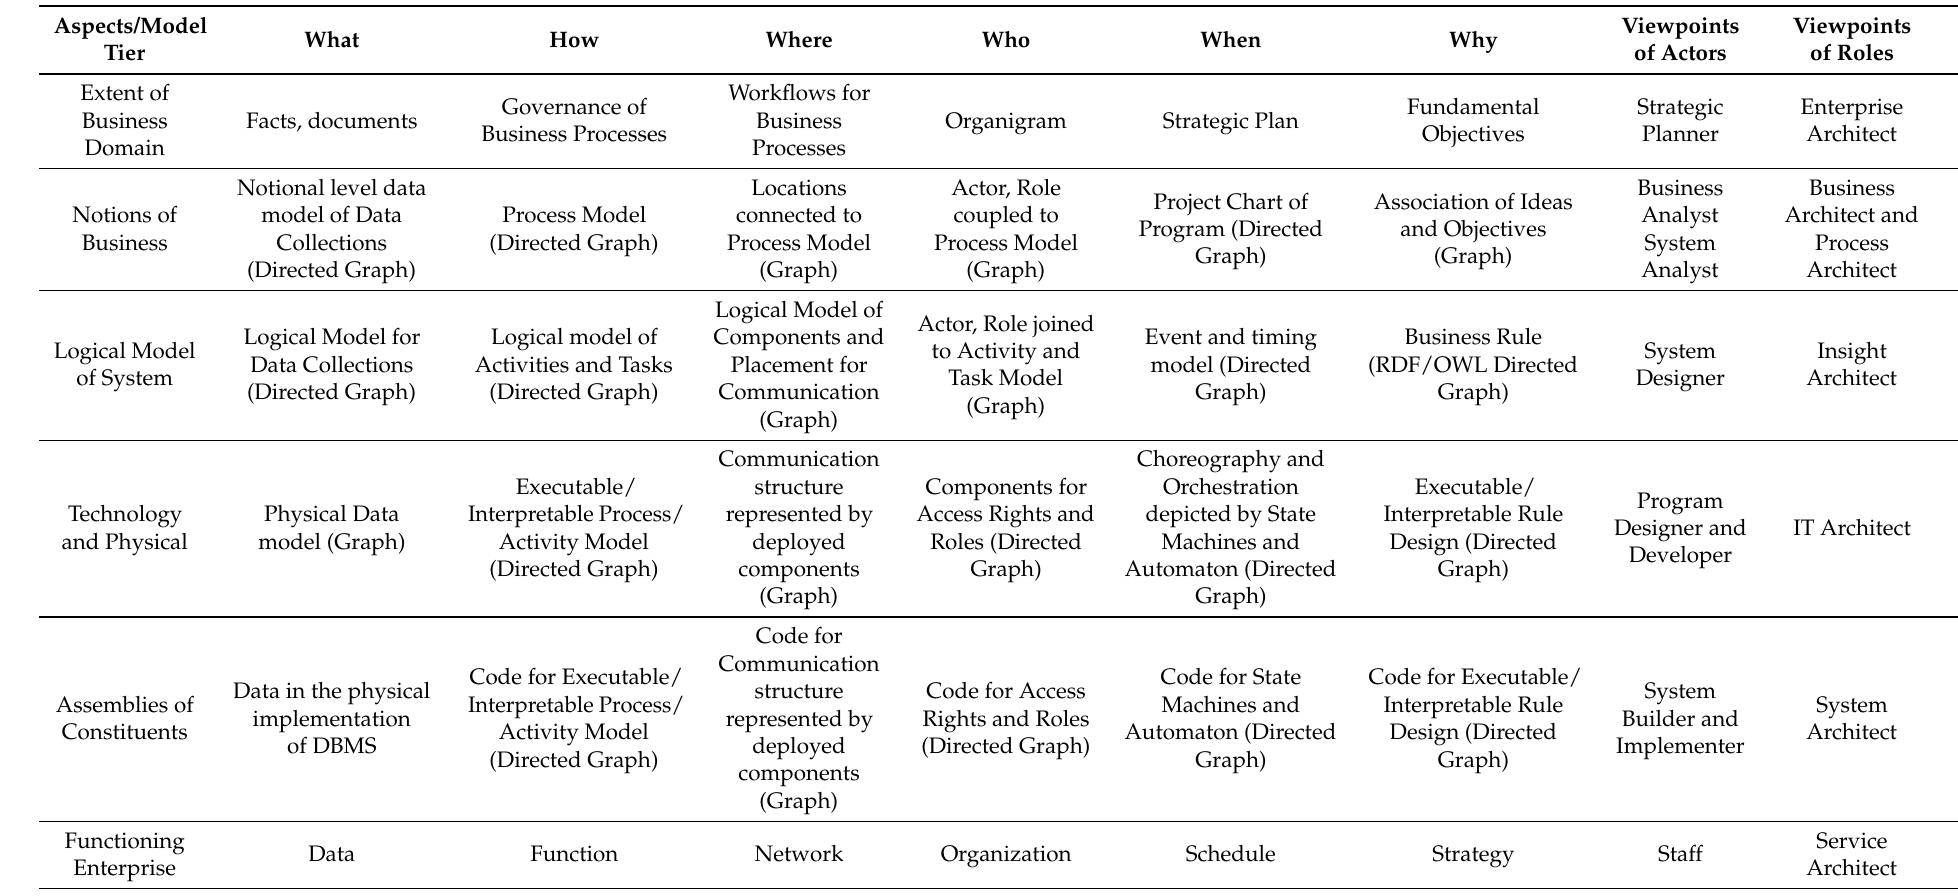
Table 2. Zachman architecture and current Information Systems’ model